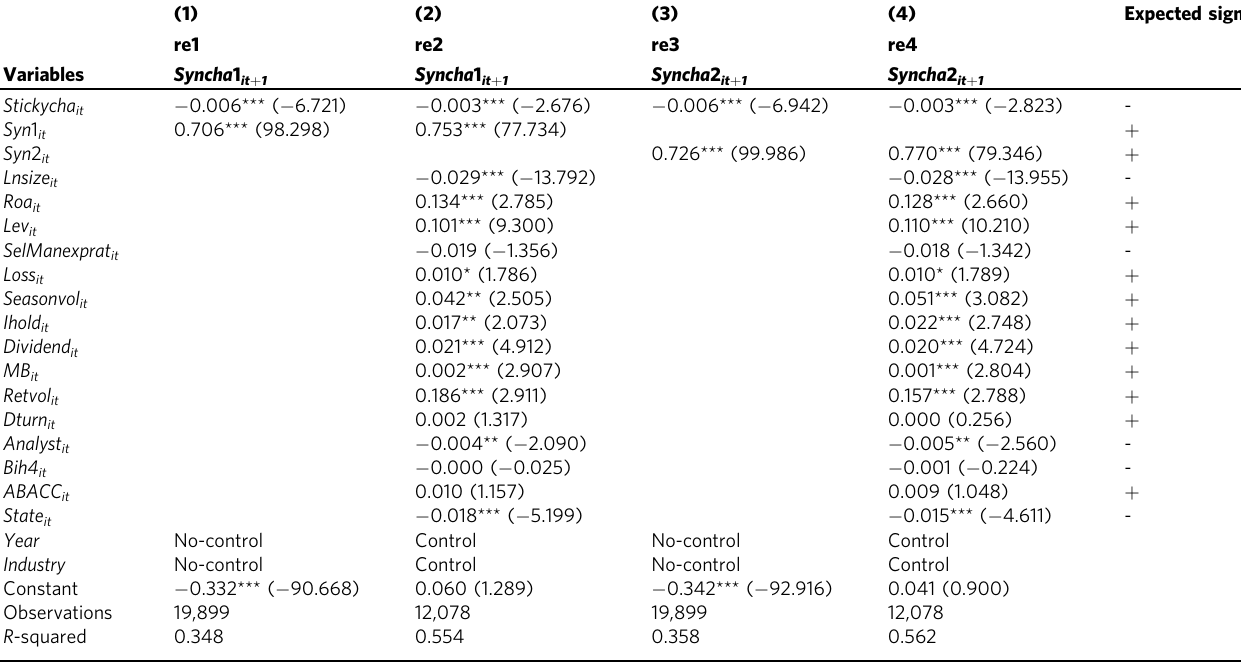
Table 5 Regression table of the change of cost stickiness and the change of stock price